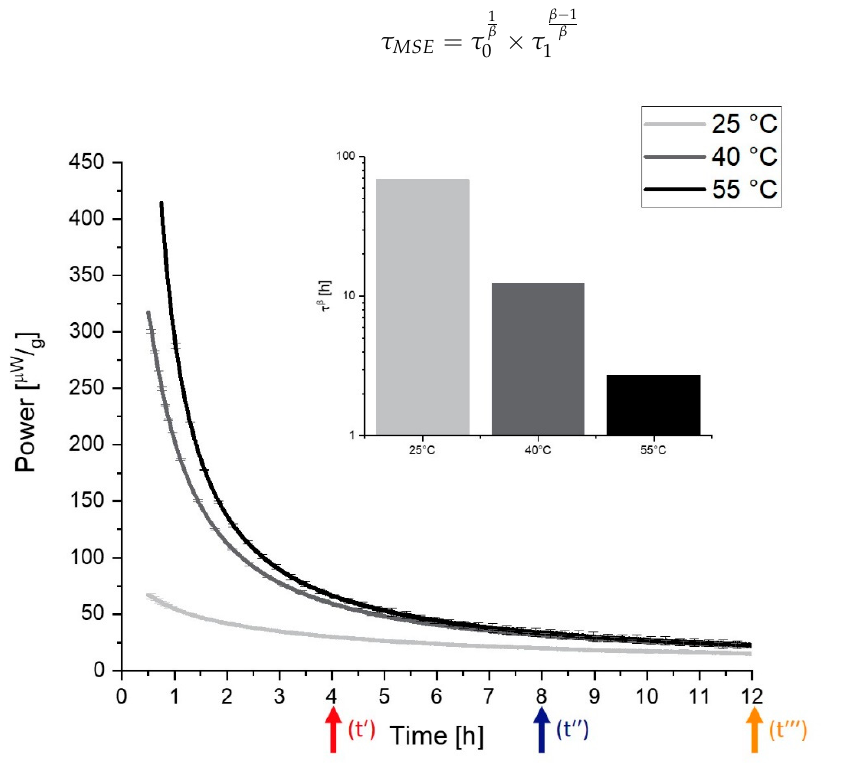
Figure 4. Relaxation curves of the same trehalose-based formulation as in Figure 2 obtained by isothermal microcalorimetry at different measurement temperatures. The small diagram represents the respective calculated τ β values. The markers (t ′ )–(t ‴ ) represent the different relaxation states of the formulation compared to Figure 1a as a fictive example.